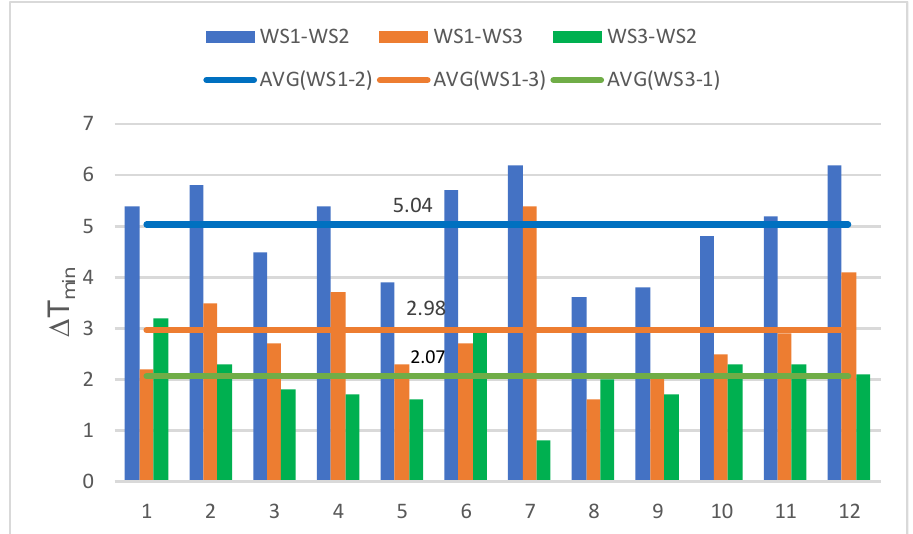
Figure 4. Difference of Tmin between WS1 – WS2 (vertical blue bars), WS1 – WS3 (vertical orange bars) and WS3 – WS2 (vertical green bars) during the 12 selected days (x axis). The horizontal bars indicate the average difference during the entire period.